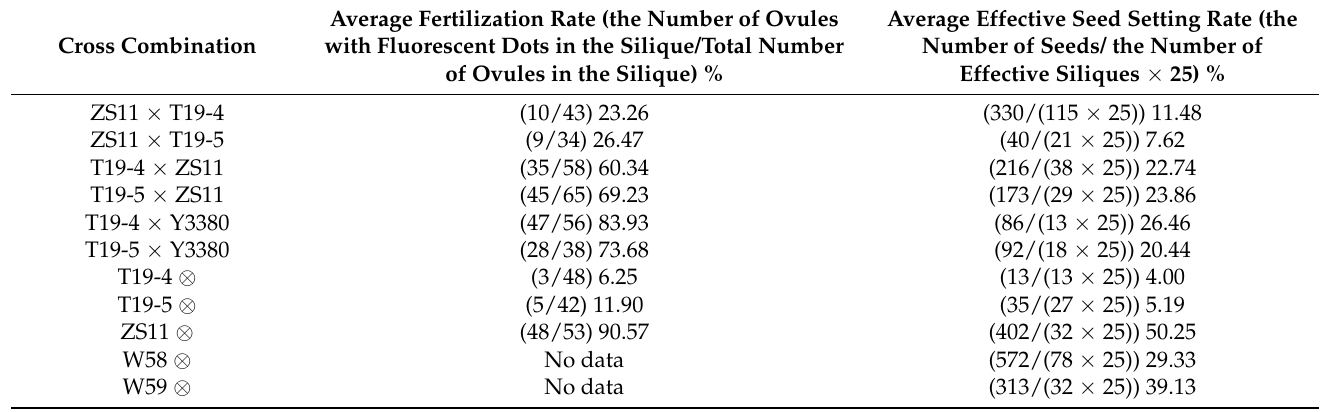
Table 1. Table of average fertilization rate and average seed setting rate of each cross combination in F 1 .